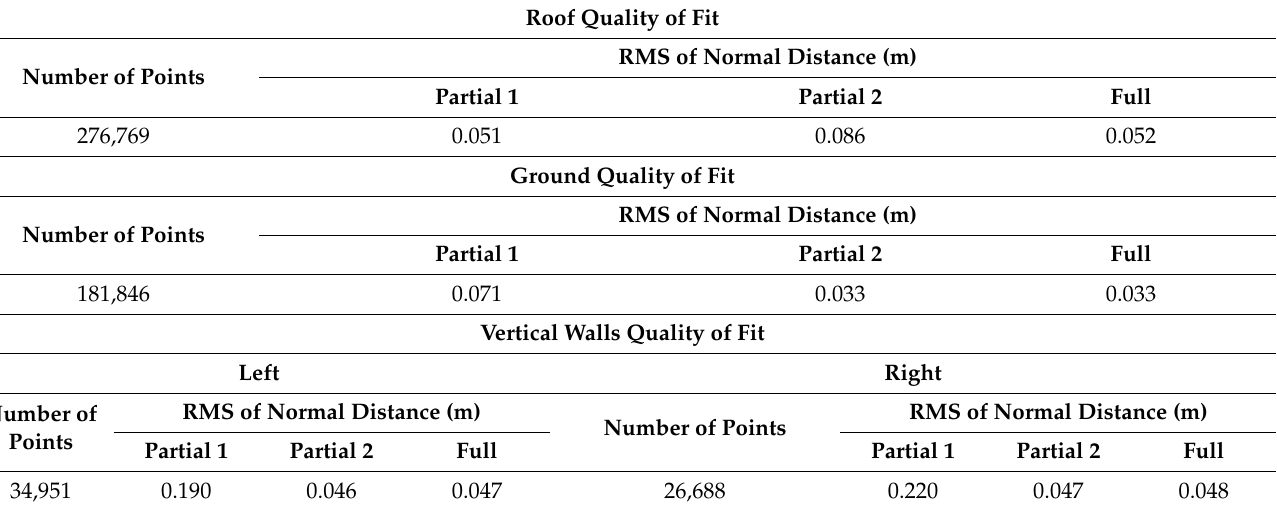
Table 5. RMS of the fitting error for the registration primitives in the Frankfort dataset after partial fine registration using the roof feature (partial 1), partial fine registration using the ground/wall (partial 2) features, and full fine registration using the roof/ground/wall